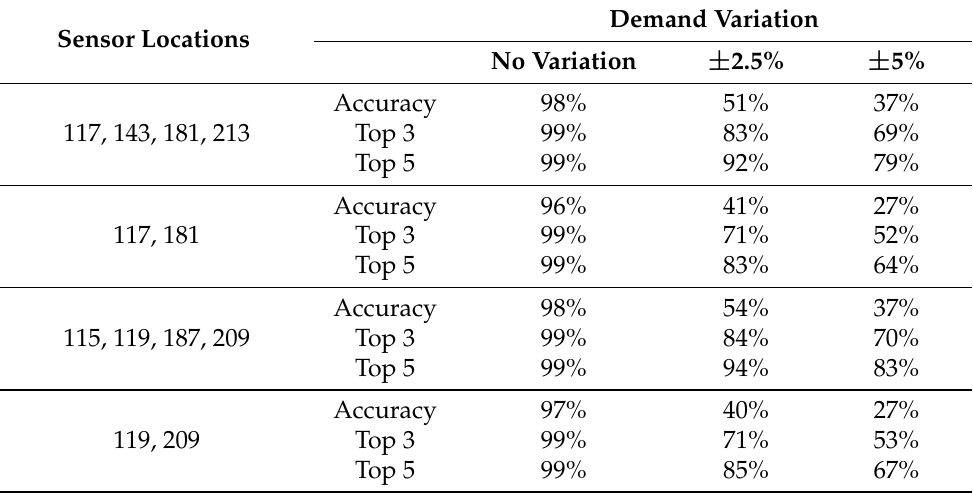
Table 6. Influence of sensor layout on model accuracy for the Net3 network for an emitter coefficient range of 5–10 with 500,000 inputs.